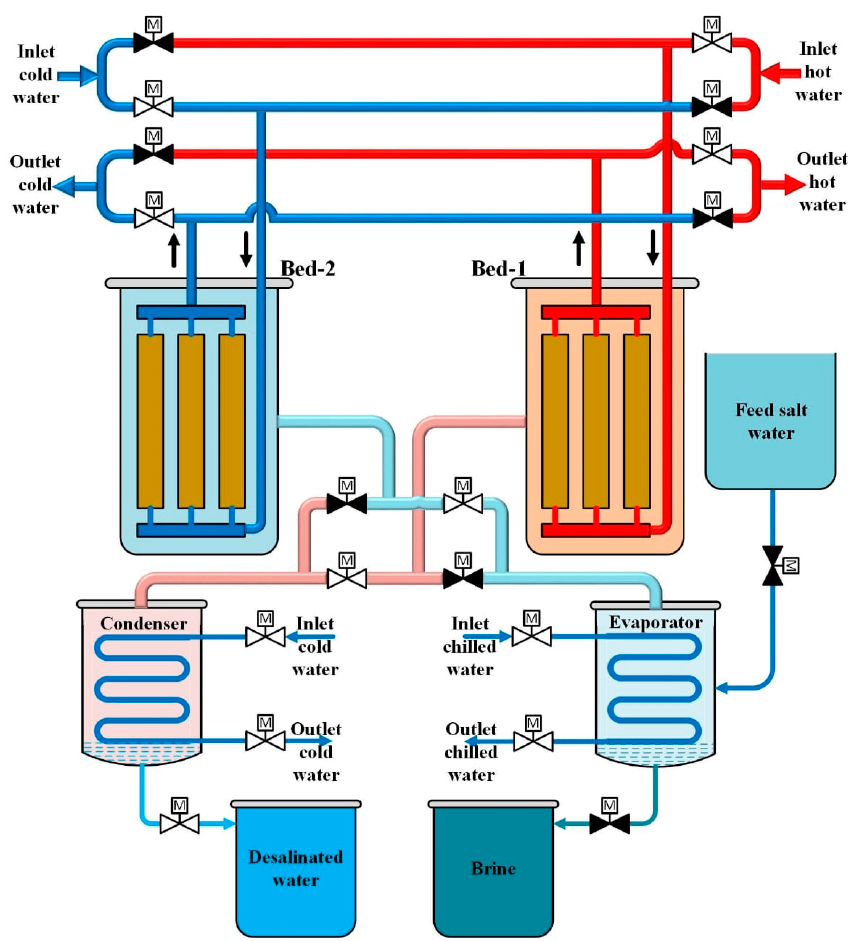
Figure 1. Two beds adsorption desalination system.